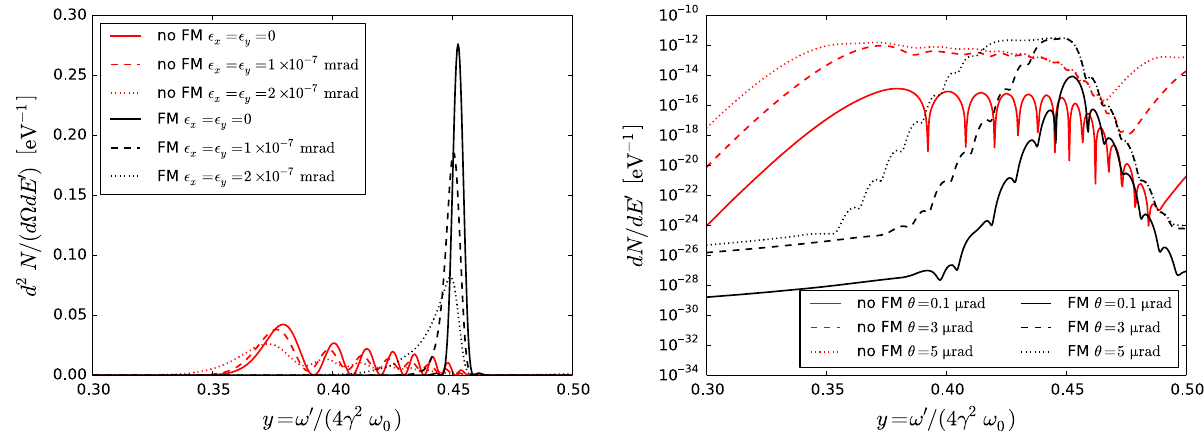
FIG. 2. Radiation spectrum for the nonlinear Compton scattering: uncompensated spectrum (no FM) is shown in red lines and optimally compensated (FM) in black. Left: Backscattered spectra ( d 2 N= ð d Ω dE 0 ) for an electron beam with zero emittance (or for a single, on-axis particle) are shown in solid lines; ε x ¼ ε y ¼ 10 − 7 m rad emittance in dashed; and ε x ¼ ε y ¼ 2 × 10 − 7 m rad emittance in dotted lines. Right: Spectra collected over a finite aperture, dN=dE 0 , for an electron beam with zero emittance (or for a single, on-axis particle) and: θ ¼ 0 . 1 μ rad shown in solid lines; θ ¼ 3 μ rad shown in solid lines; θ ¼ 5 μ rad shown in solid lines. The solid red and black lines in both panels correspond to the same-colored lines in the top panel of Fig. 4 in Ref. [20] and the top panel of Fig. 2 in Ref. [21]. Spectra shown are for a linearly polarized 800-nm laser with pulse duration of 21 fs and a 0 ¼ 1 on an Gaussian-distributed electron beam with mean energy of 51